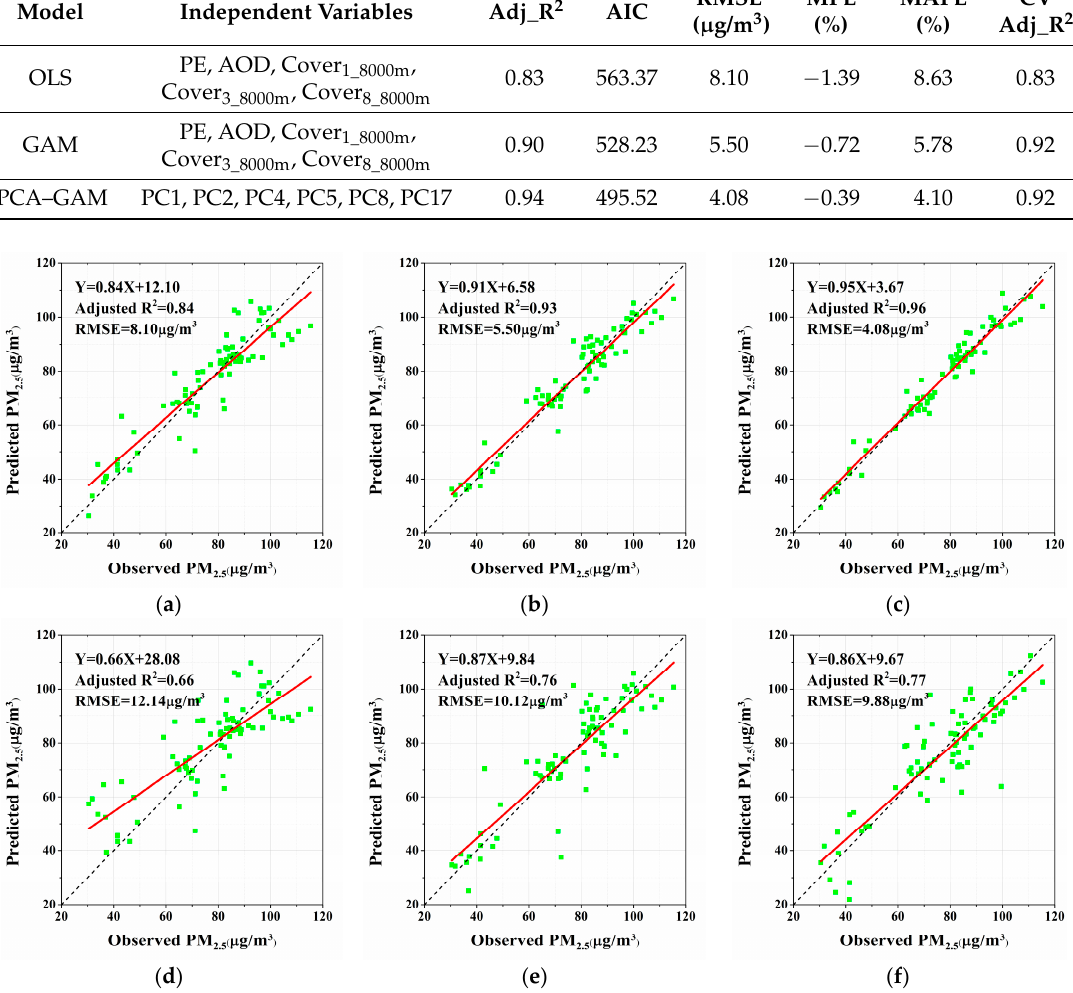
Figure 5. Scatter plots of fitting and validating results for three models. ( a ) OLS model fitting results; ( b ) GAM model fitting results; ( c ) PCA–GAM model fitting results; ( d ) OLS model validating results; ( e ) GAM model validating results; and ( f ) PCA–GAM model validating results.